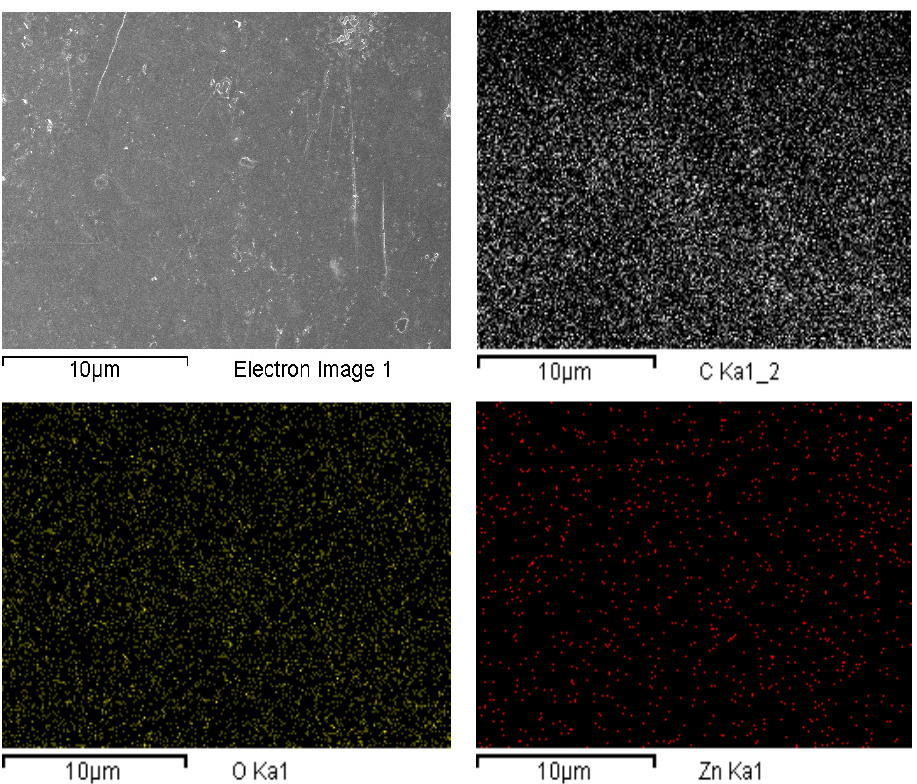
Figure 2. EDX mapping showing the particle distribution of the coatings containing 2 wt.% ZnO nanoparticles.